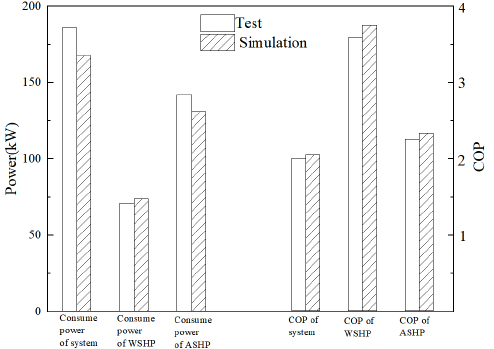
Figure 12. Comparison between simulation and test.